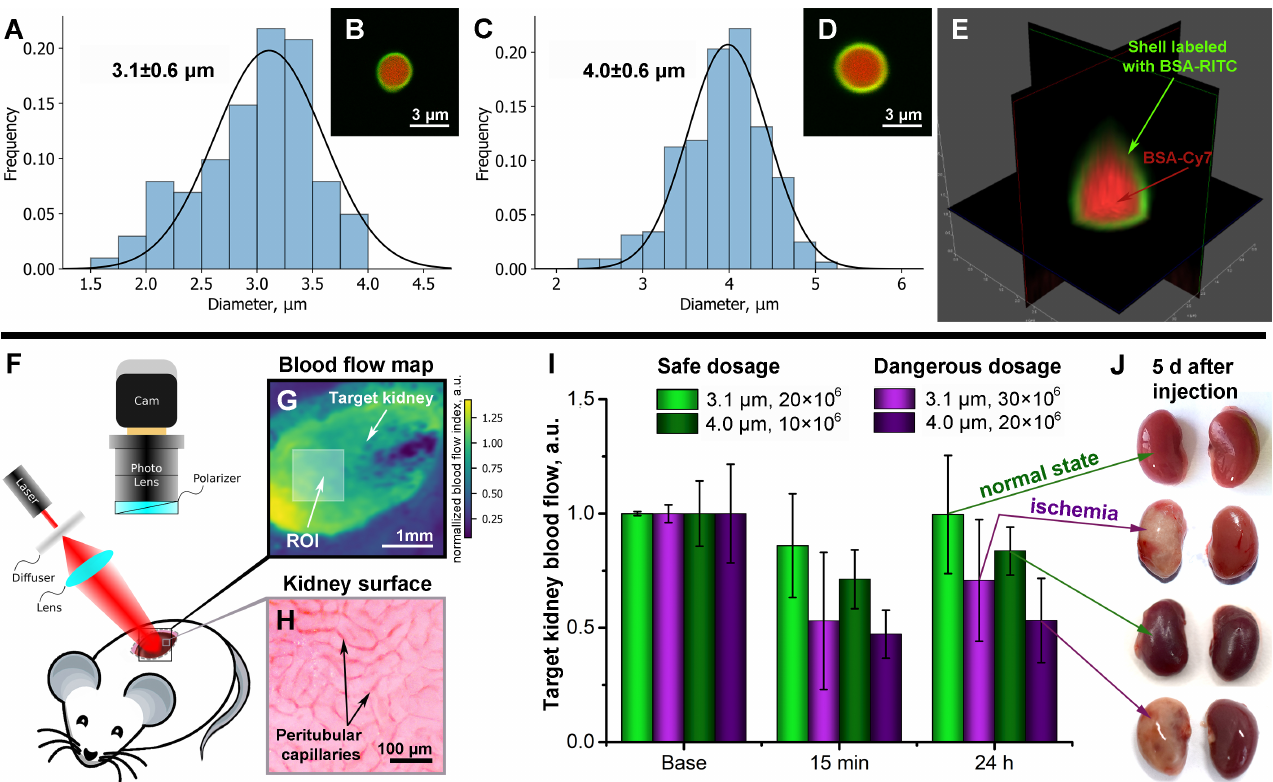
Figure 2. Characterization of polyelectrolyte microcapsules with two sizes ( A – D ). Size distribution with Gaussian fit ( A , C ) and typical CLSM images ( B , D ) in aqueous solution. CLSM 3D image of typical polyelectrolyte microcapsule ( E ). Green color indicates a shell labeled with BSA-RITC. Red color indicates the encapsulated cargo (BSA conjugated with Cy7) ( B , D , E ). The general scheme of the experiment on the registration of mouse kidney blood flow using the laser speckle contrast analysis system ( F ). Typical laser speckle contrast image (LSCI) of the target kidney surface (( G ); scale bar, 1 mm). Bright-field microscopy image of superficial peritubular capillaries of the mouse’s kidney that forms the LSCI signal ( H ). Dose-dependent changes of target kidney blood flow before and 15 min and 24 h after the different size microcapsules’ injection via the left renal artery measured using the laser speckle contrast analysis system ( I ). The typical photos of the target kidney 5 days after microcapsules’ injection via the renal artery ( J